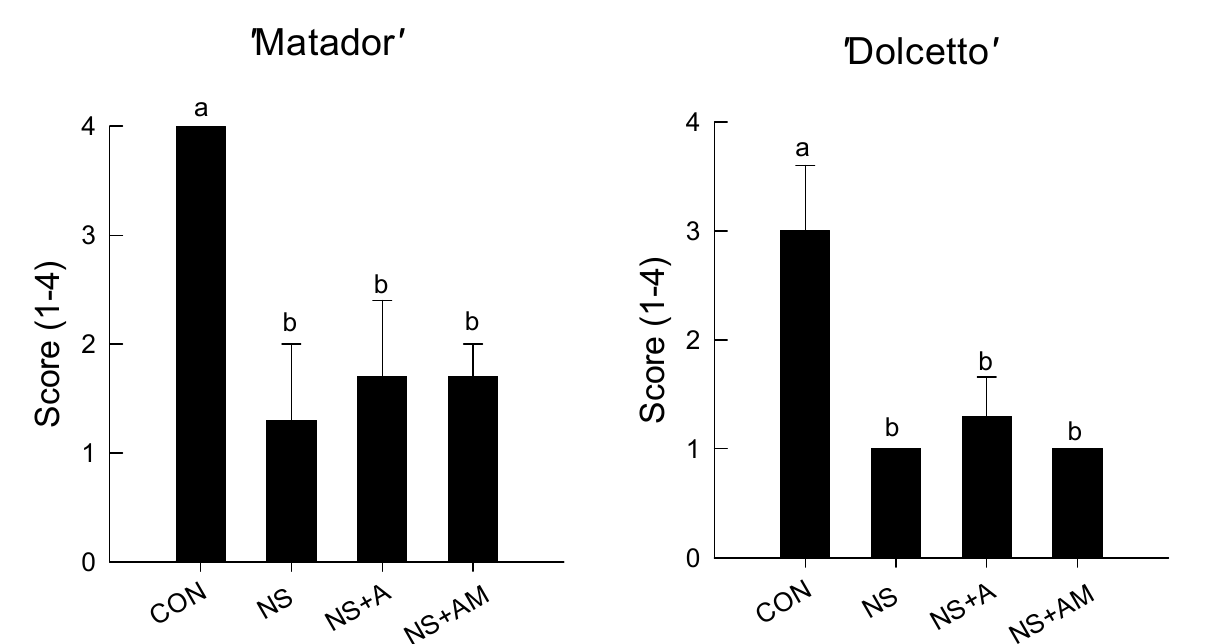
Figure 2. Bacterial population at the cut stem ends of ‘Matador’ and ‘Dolcetto’ rose cultivars after 4 days of the treatment. CON, control flowers were held in DW; NS, cut roses were treated with nano silver; NS+A, cut roses were treated with NS and AIB; NS+AM, cut roses were treated with NS, AIB, and 1-MCP. All cut roses were exposed to ethylene (2 µL L − 1 ) for 24 h at 25 ± 1 °C under dark conditions. Score: (1), 0 colony; (2), 1–10 colonies; (3), 10–50 colonies; and (4), >50 colonies. Different letters above bars show statistically significant differences among treatments at p < 0.05 based on DMRT. Vertical bars indicate SE of the means ( n = 6).